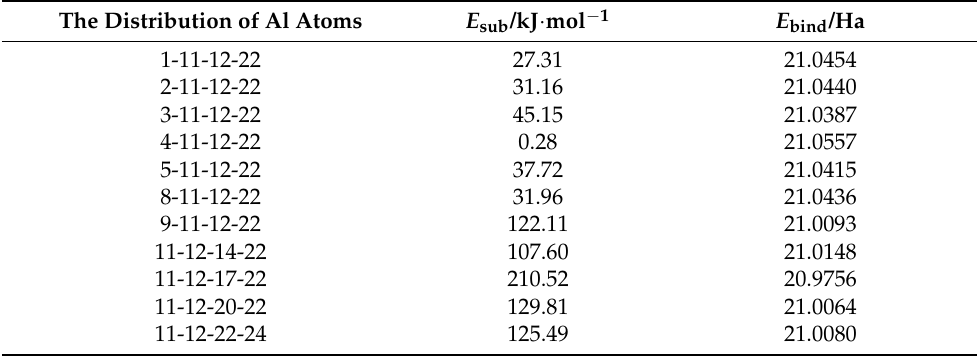
Table 2. The substitution energies ( E sub ) and binding energies ( E bind ) for the Y 4 − cluster with different distribution of Al atoms.